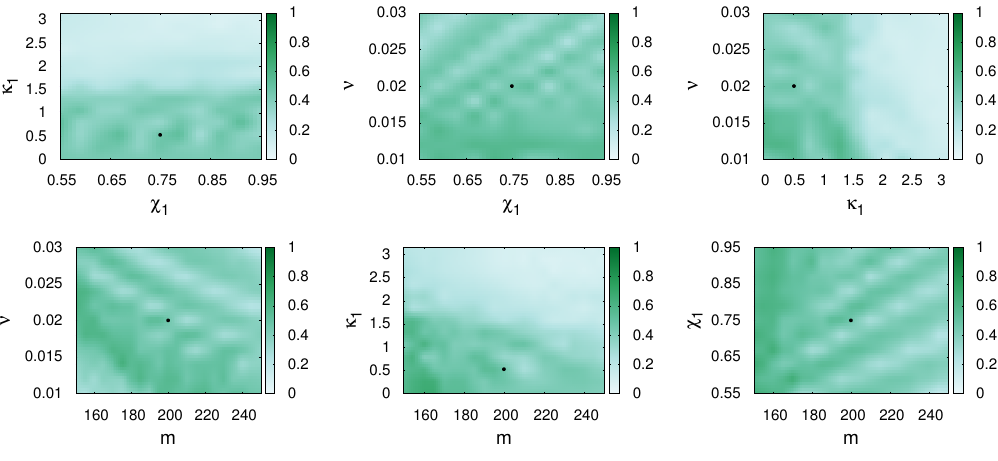
Figure 6. The match values M between SpinTaylorT4 and SpinDominatedWf are presented in the parameter planes ( κ 1 , χ 1 ), ( ν , χ 1 ), ( ν , κ 1 ), ( ν , m ), ( κ 1 , m ) and ( χ 1 , m ). The parameters of the first waveform (the template, SpinTaylorT4) are varied, while those of the second waveform (the signal, SpinDominatedWf, represented by a dot) are fixed as. m = 200 M (cid:12) , ν = 0.02, χ = 0.75 and κ 1 = 0.5. The other parameters were chosen as f low = 10 Hz, ι = 0.5. Spins are precessing in this